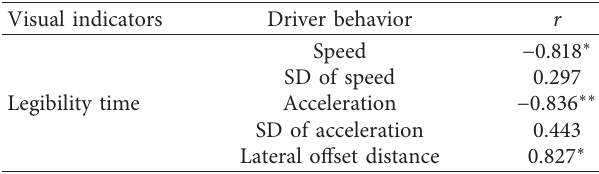
Table 2: Pearson correlation. Visual